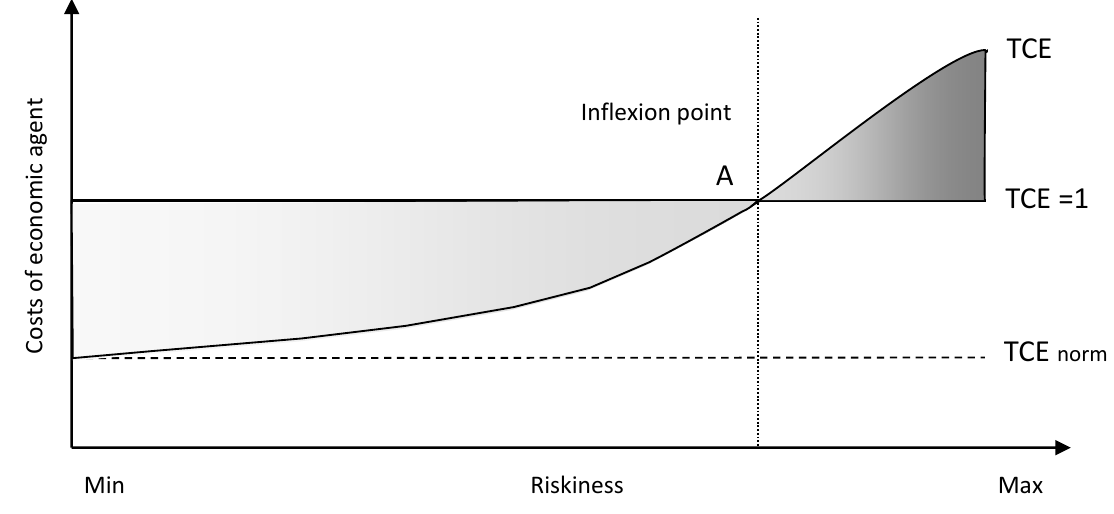
Figure 1. Function of transaction